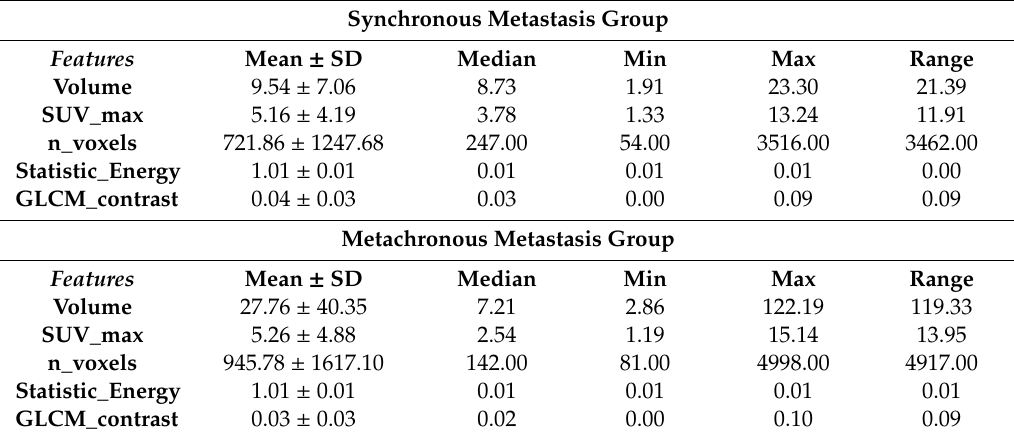
Table 2. Descriptive statistics of features extracted from PET